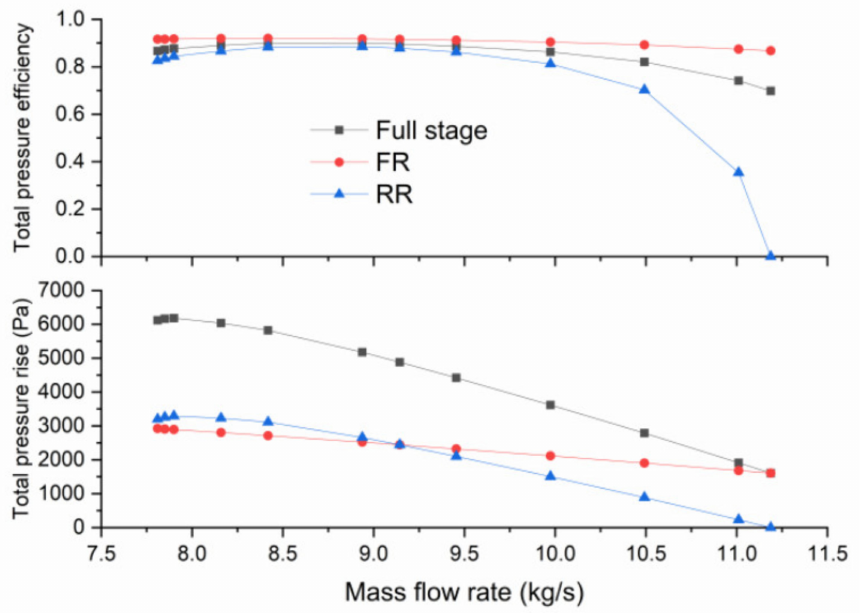
Figure 8. CFD results of the baseline CRF